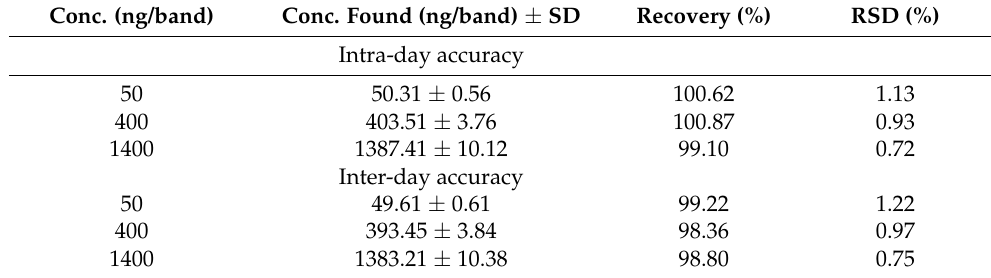
Table 4. Intra-day and inter-day accuracy data of FFA for the ecofriendly HPTLC assay (mean ± SD; n =